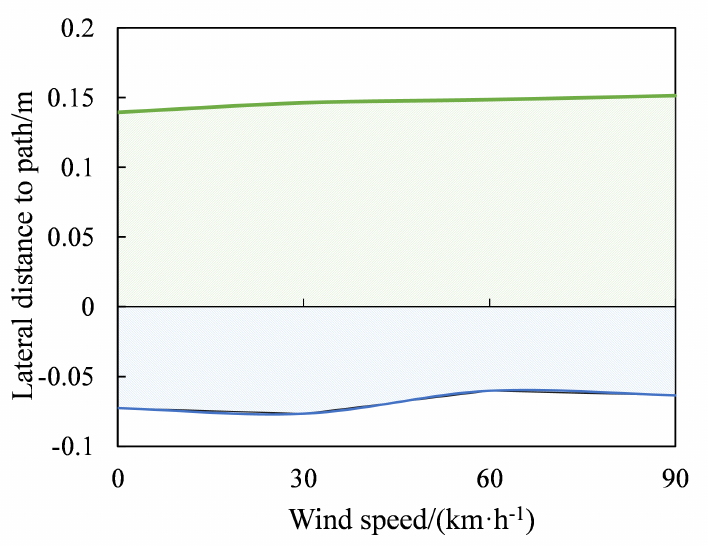
Figure 15. Range of tractor-trailer lateral offset distance under different wind speed.